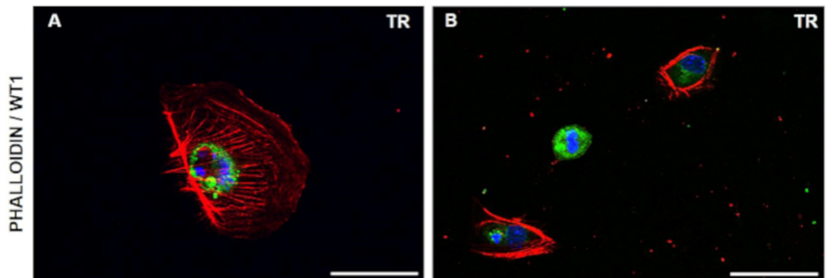
Figure 3. Actin distribution. Stress fibers (red) are visible in podocytes as dorsal, ventral, and transverse arcs ( A ), or disrupted and distributed along the edge of the cell and poorly expressed in the cytoplasm. ( B ) Double staining with nuclear podocyte marker WT1 (green) to demonstrate podocyte staining and DAPI (blue) nuclear marker. Scale bar is 100 µm .